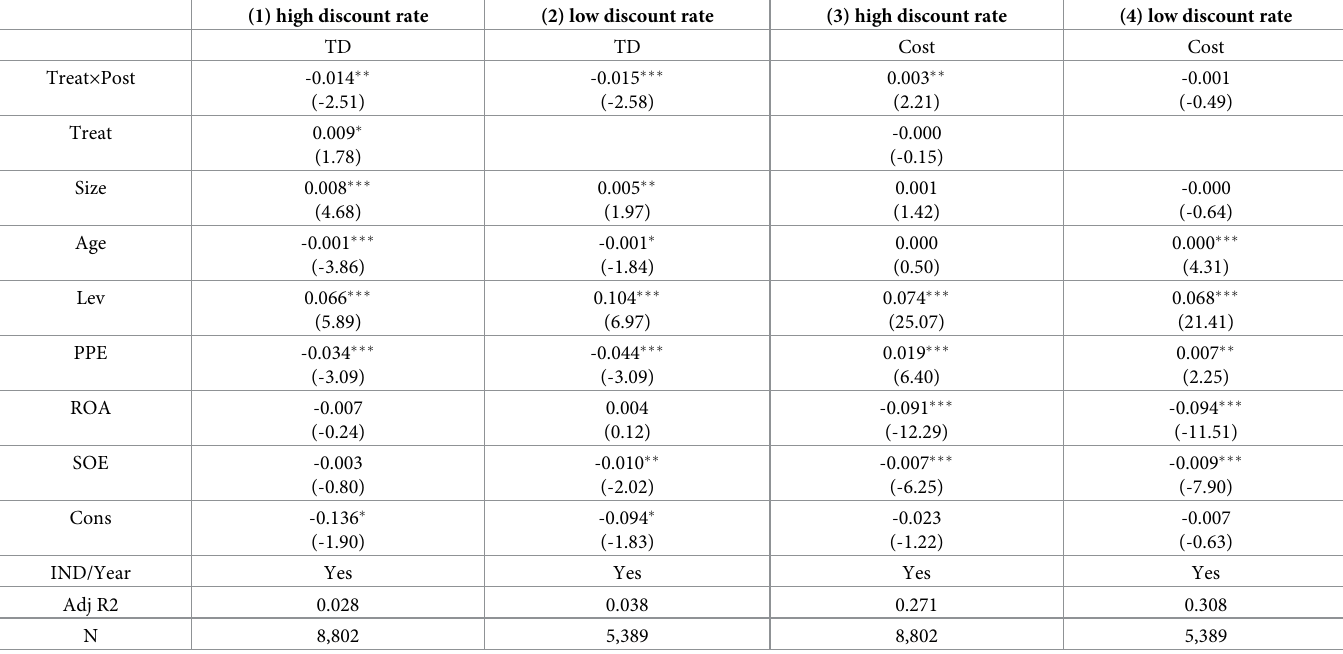
Table 5. Analysis results of